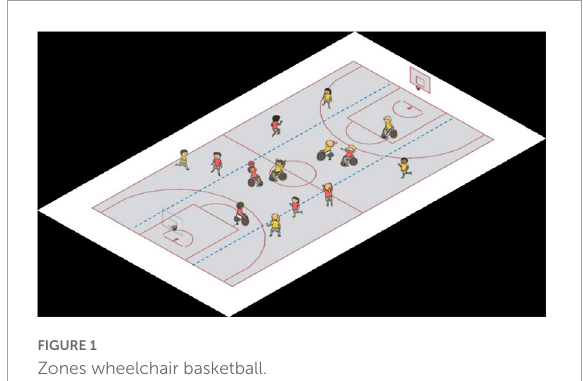
FIGURE1 Zones wheelchair